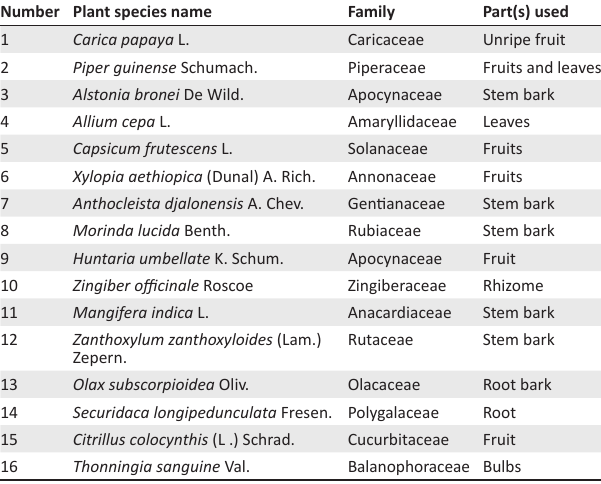
TABLE 13: Names of plants and their parts used for the formulation of traditional oral powdered herbal formulations for the treatment of typhoid fever in Ogbomoso, Nigeria.